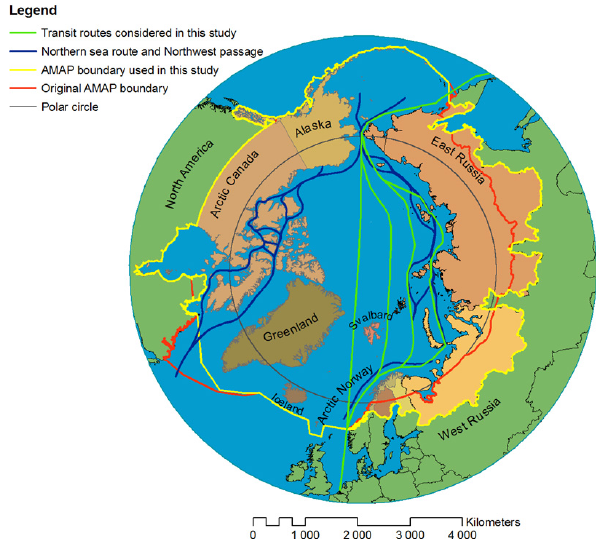
Fig. 1. The Arctic Monitoring and Assessment Programme (AMAP) boundary used in this study compared to the official AMAP boundary. For the oil and gas modelling, the AMAP area is further split into regions: Arctic Canada, Alaska, East and West Russia, Arctic Norway (not including Finland or Sweden), and